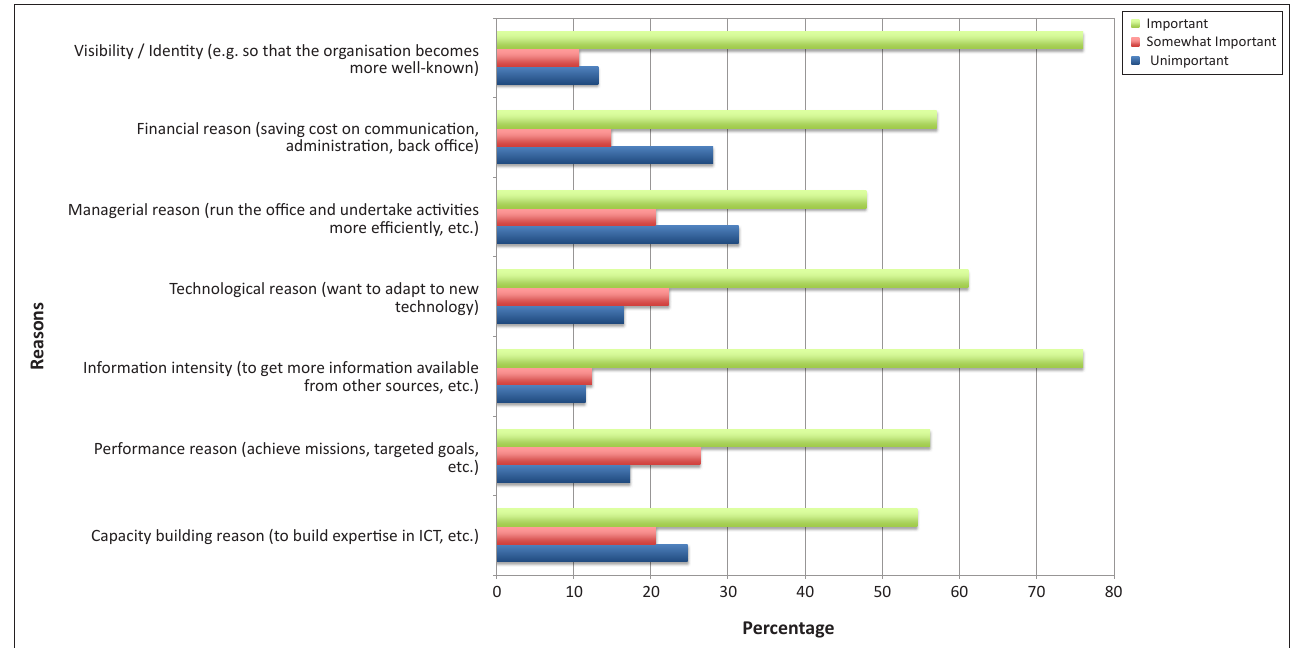
FIGURE 1: Internal reasons for Web 2.0 adoption amongst South African civil society